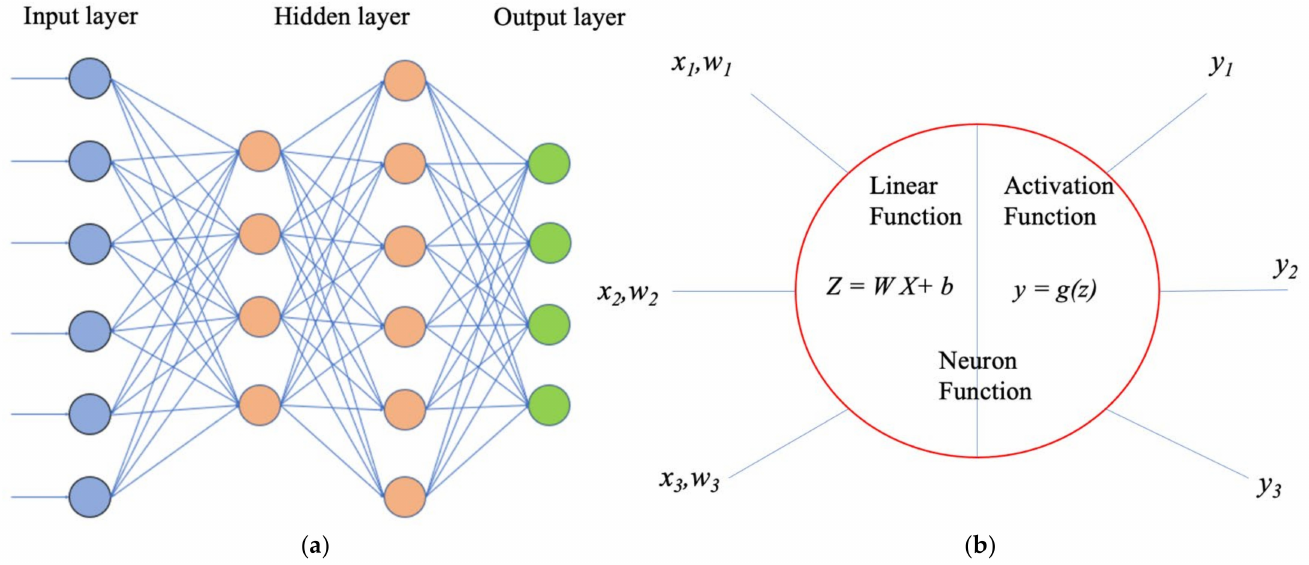
Figure 2. The structure of an artificial neural network: ( a ) the structure of neural network; ( b ) neuron function. Each layer consists of an array of neurons, and their components are described as